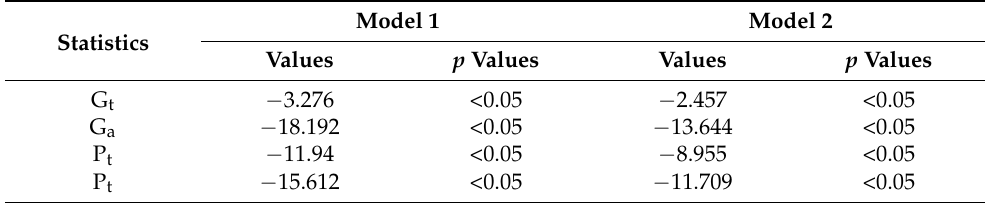
Table 5. Westerlund test for